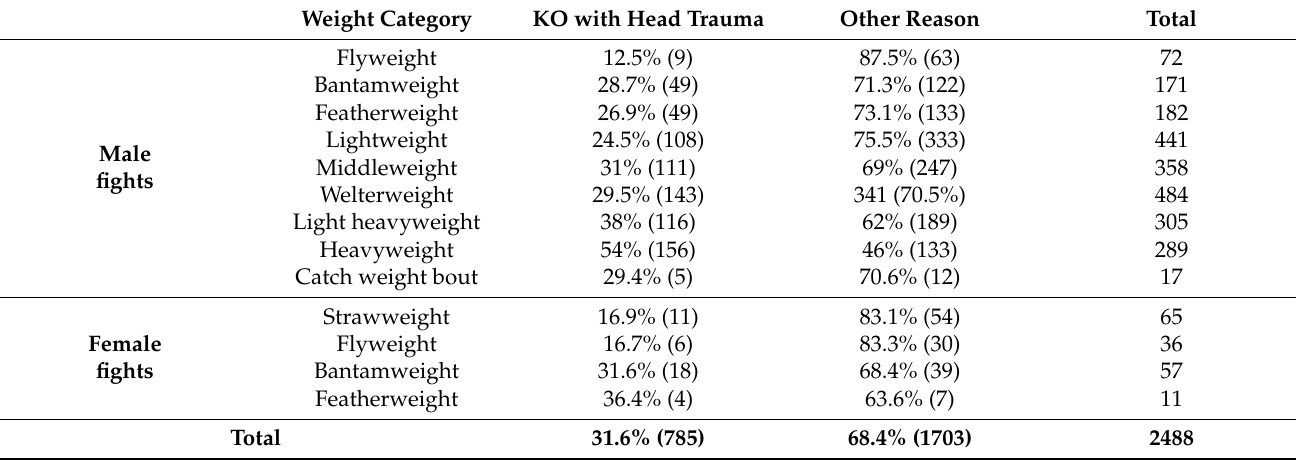
Table 2. Fights ended due to the KO with head injury versus all fights divided by weight category. The percentages and (raw numbers) are presented.